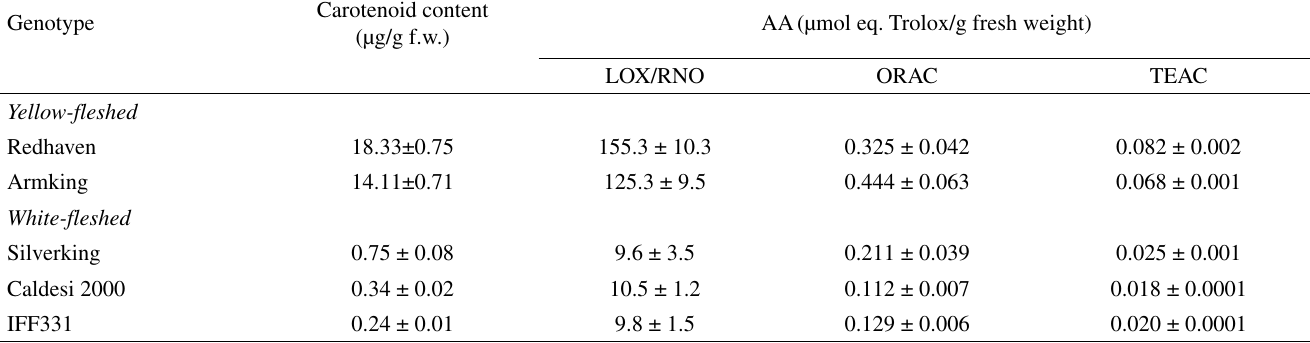
Table 1 - Antioxidant Activity (AA), evaluated by means of the LOX/RNO, ORAC and TEAC methods, and carotenoid content of extracts from yellow- and white-fleshed peach genotypes Carotenoid content Genotype